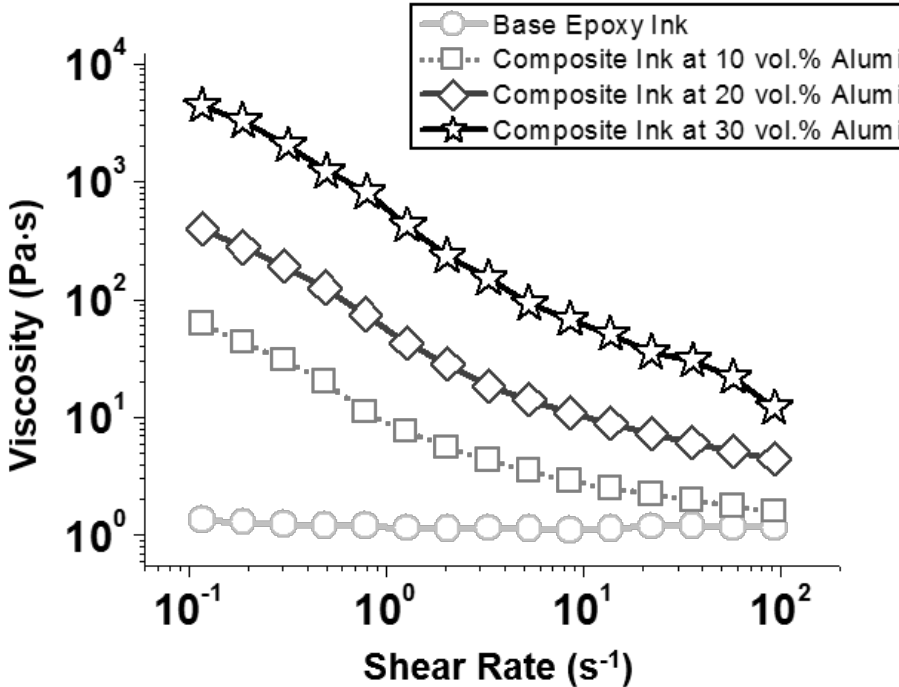
Figure 1. Viscosities of uncured base and alumina-suspended (10–30 vol.%) epoxy inks, measured using rotational viscometry within applied shear rate range between 0.1 and 100 s − 1 . The addition of solid particles thickened the ink, which was apparent from the sig- nificant increases in the measured viscosities with the increase in particle